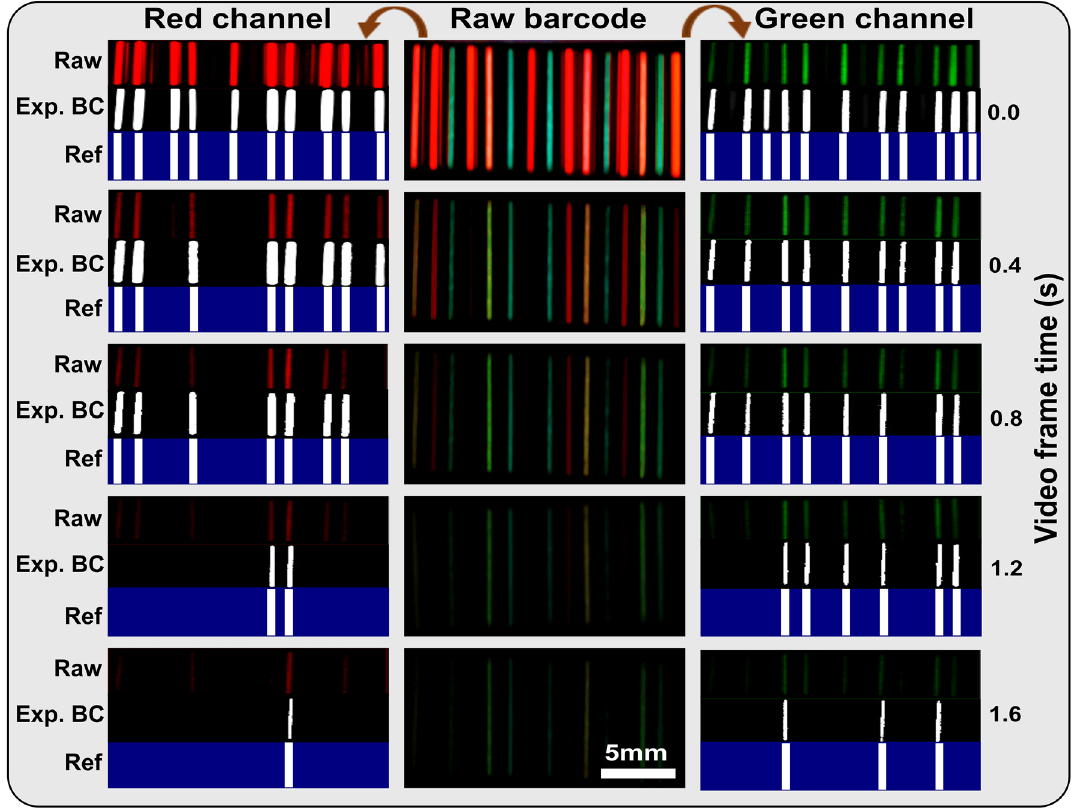
Figure 5. A multi-color-tunable 15-line dynamic barcode registering different dynamic codes following evaluation of the red and green channel of the emission. From left to right the raw barcode lines have the 2 + following samples SAED (850) in line 11, SAED (840) in line 3, SAED (830) lines 6, 8 and 14, Ca 0.999 S:Eu 0.001 2 + Ca 0.9 S:Eu 2 + Sr 0.99 S:Eu 2 + (lines 9), Ca 0.996 S:Eu 0.004 , (lines 2 and 12), 0.01 (lines 7), and 0.01 , in line 4, and Sr 0.994 S:Eu 2 + 0.006 , line 15. Blended phosphors shown in Fig. 3b include phosphors (i) in line 10, phosphor (ii) in line 5 and line 13. The barcodes remain on (‘1’) when above the threshold parameter and off (dark) when below after the splitting of the red and green channels. For each barcode, the raw barcode is shown alongside the processes barcode and the reference barcode for authentication at the various time